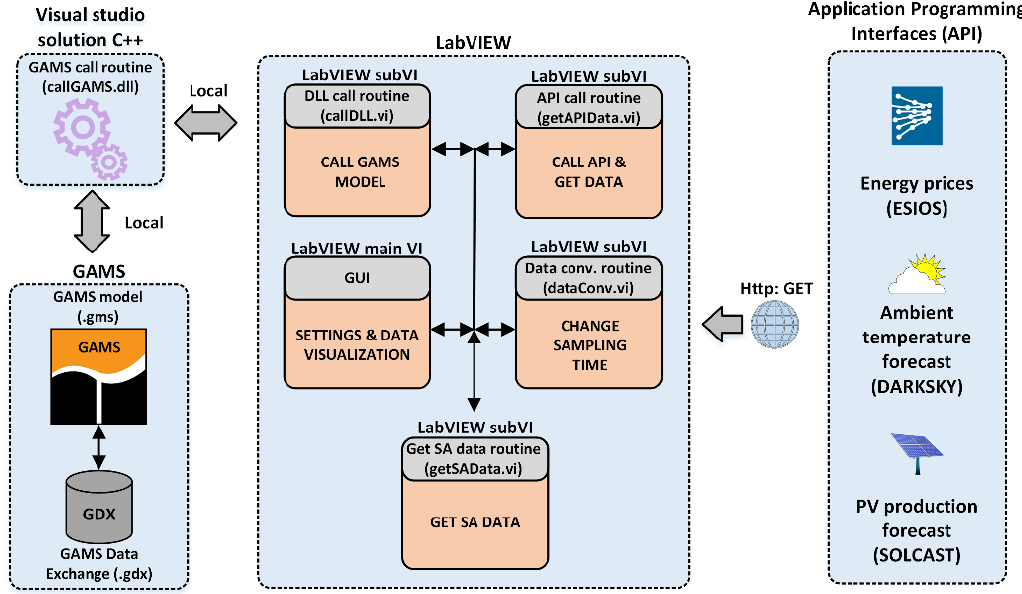
Figure 1. Smart appliances (SA) control testbed overview. 219